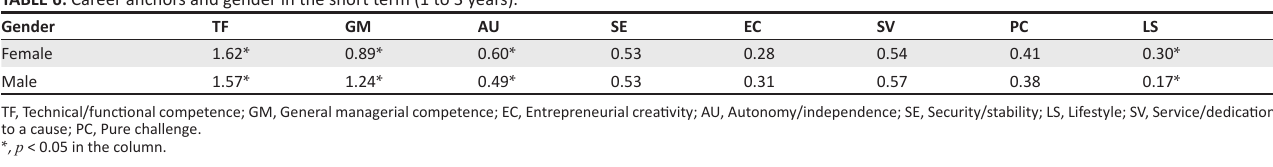
TABLE 5: Career anchors and race in the medium term (4 to 10 years). Race TF GM AU African people Indian people White people